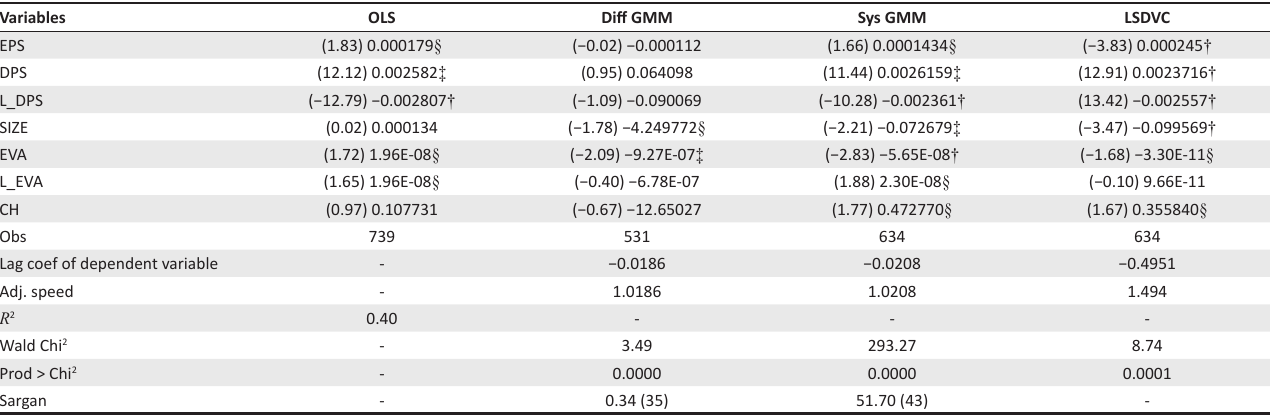
TABLE 5: Regression results for the dividend relevance pay-out model and determinants of change in dividends–Panel 1.